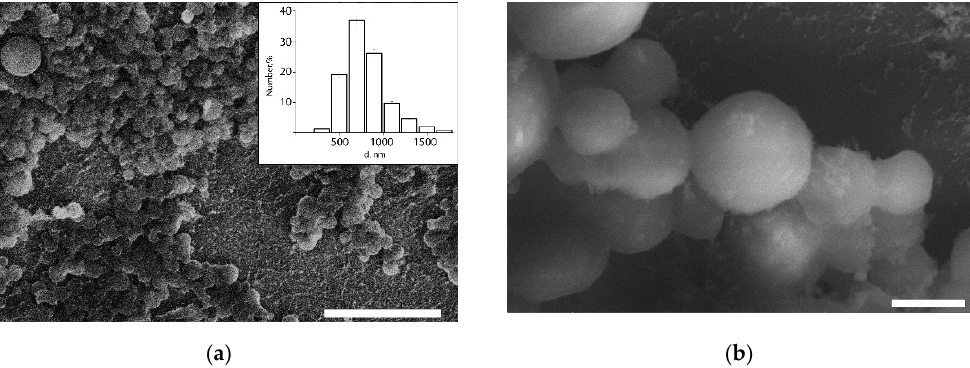
Figure 6. Cryo-SEM images ( a , b ) and size distribution of the colloidosomes (inset in Figure 6a) with the shell of the nanoparticle mixture with 80 wt.% of DNDs. Scale bars are 10 μ m ( a ) and 1 μ m ( b ).